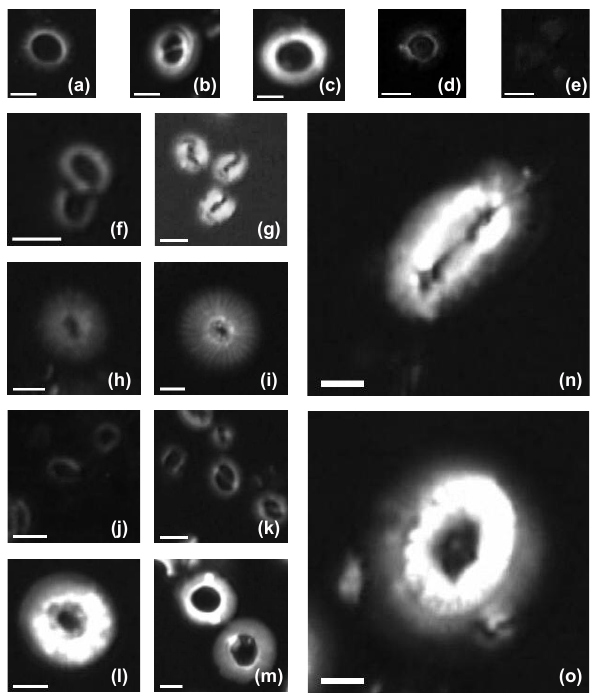
Figure B1. Imaged of coccoliths measured in this study: (a) Pseudoemiliania lacunosa in the core ODP 807; (b) Gephyrocapsa ocean- ica in the core KX21-2; (c) Reticulofenestra spp. (large) in the core IODP U1433B; (d) Umbilicosphaera sibogae in the core ODP 807; (e) Florisphaera profunda in the core KX21-2; (f) Reticulofenestra spp. (small) in the core IODP U1433B; (g) Gephyrocapsa caribbeanica in the core IODP U1304B; (h) small Calcidiscus leptoporus in the core IODP U1304B; (i) large Calcidiscus leptoporus in the core ODP 807A; (j) Emiliania huxleyi in the surface sediment in the South China Sea; (k) Gephyrocapsa spp. in the core ODP 807; (l) Cyclicargolithus floridanus in the core IODP U1435A and (m) dissolved Cyclicargolithus floridanus in the same core; (n) Helicosphaera carteri in the core ODP 807A; (o) Coccolithus pelagicus in the core IODP U1304B. White bars represent a length of